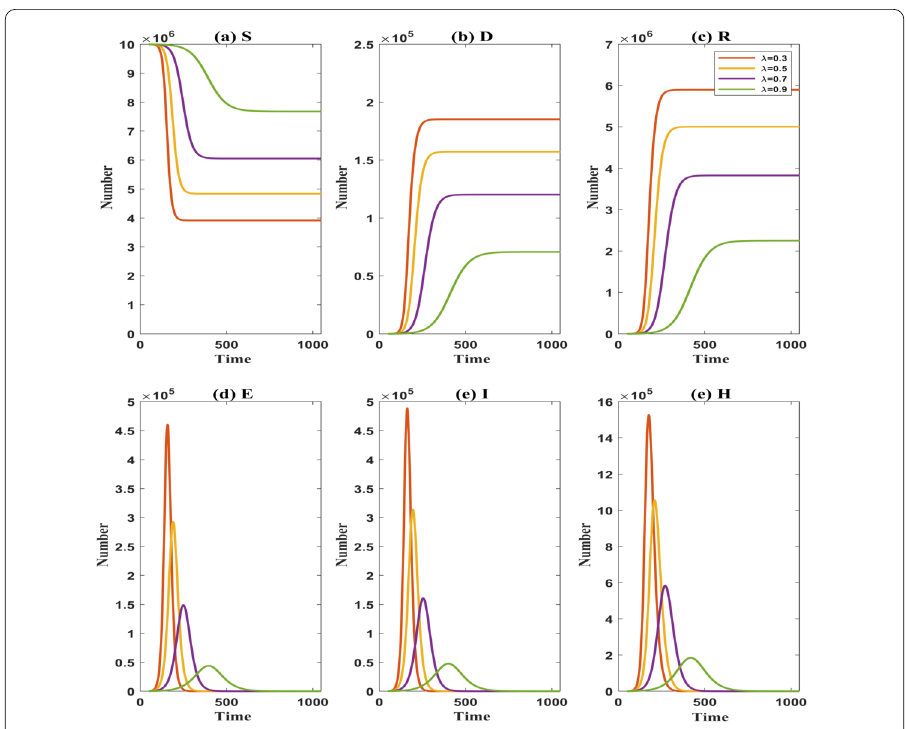
Figure 4 The evolution of the susceptible population ( S ), the exported population ( E ), the symptomatic infected population ( I ), the hospitalized population ( H ), the recovered population ( R ), and the death population ( D ) over time with λ = 0.3,0.5,0.7,0.9. ( a ): the number of S ; ( b ): the number of D ; ( c ): the number of R ; ( d ): the number of E ; ( e ): the number of I ; ( f ): the number of